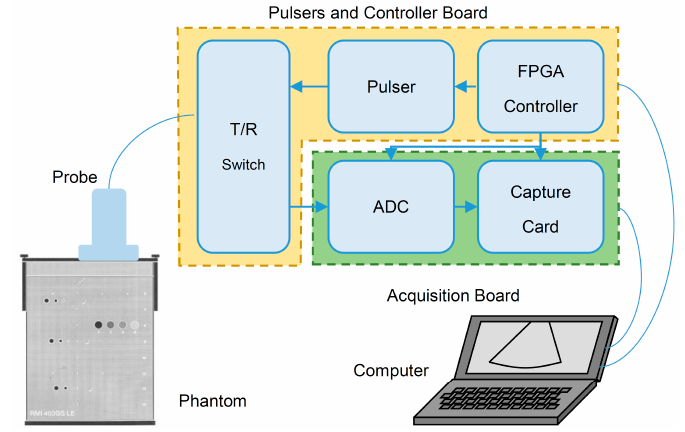
Figure 1. The schematic of our ultrasound imaging system with a tissue-mimicking phantom and a computer. T/R, transmit/receive.